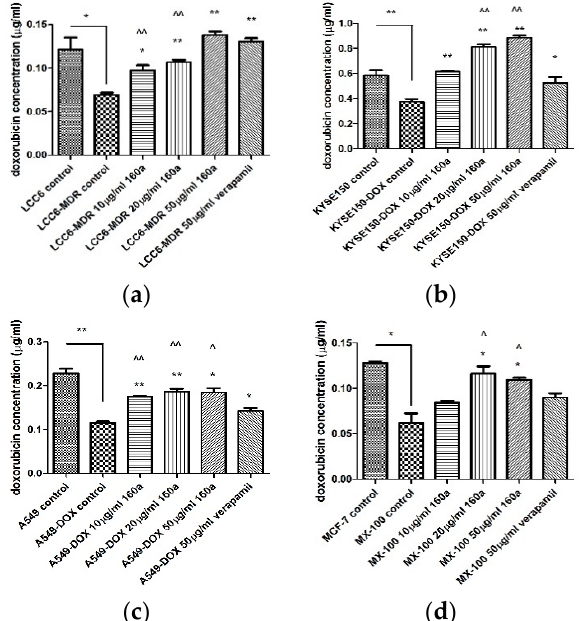
Figure 8. Effect of compound 160a on intracellular DOX accumulation in parental/DOX-resistant cells. ( a ) Intracellular doxorubicin concentration of LCC6/LCC6 MDR cells treated with compound 160a; ( b ) Intracellular doxorubicin concentration of KYSE150/KYSE150-DOX cells treated with compound 160a; ( c ) Intracellular doxorubicin concentration of A549/A549-DOX cells treated with compound 160a; and ( d ) Intracellular doxorubicin concentration of MCF-7/MX-100 cells treated with compound 160a. DMSO (0.1%) was applied as a negative control; 50 μ g/mL verapamil was applied as a positive